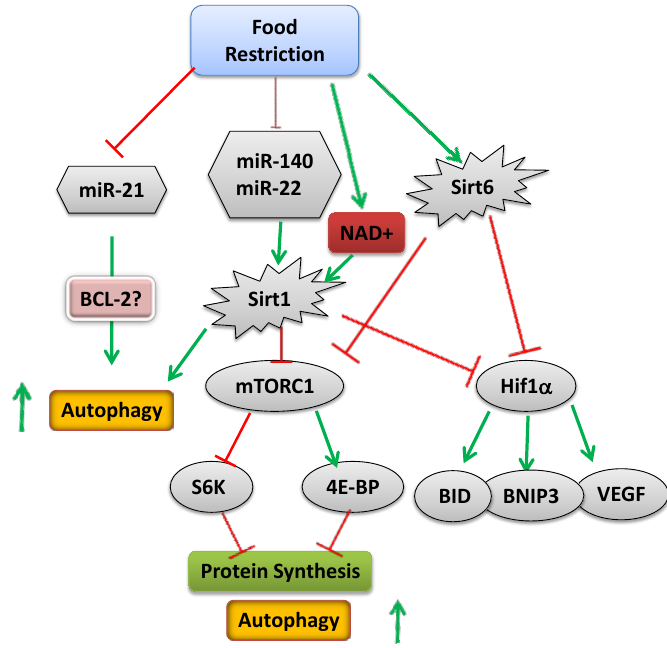
Figure 4. Schematic representation of the mechanism activated upon food restriction (green arrows indicate increased activity or level; red arrows indicate reduced activity or